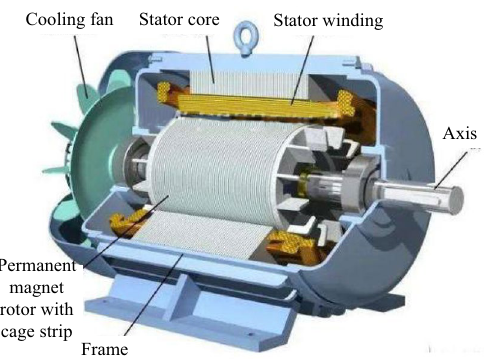
Figure 3. Structure of synchronous motor.